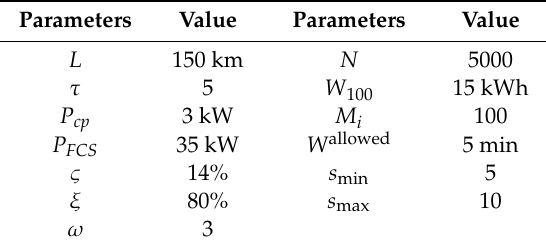
Table 2. Setting of some crucial